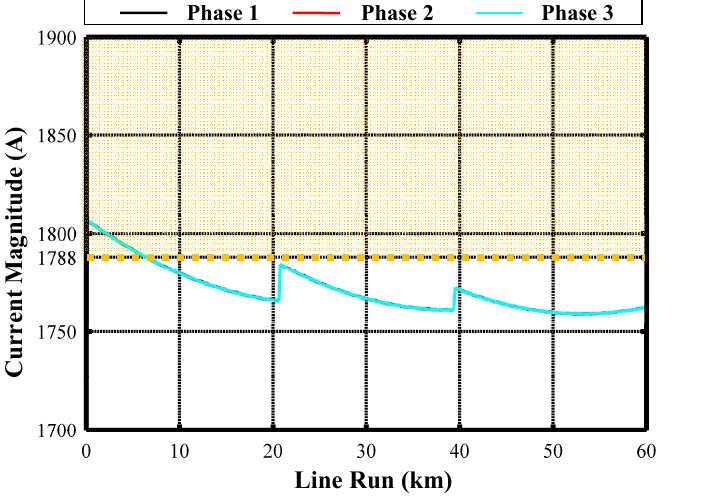
Figure 9. Phase current magnitudes along the compensated single-circuit cable, in CB with